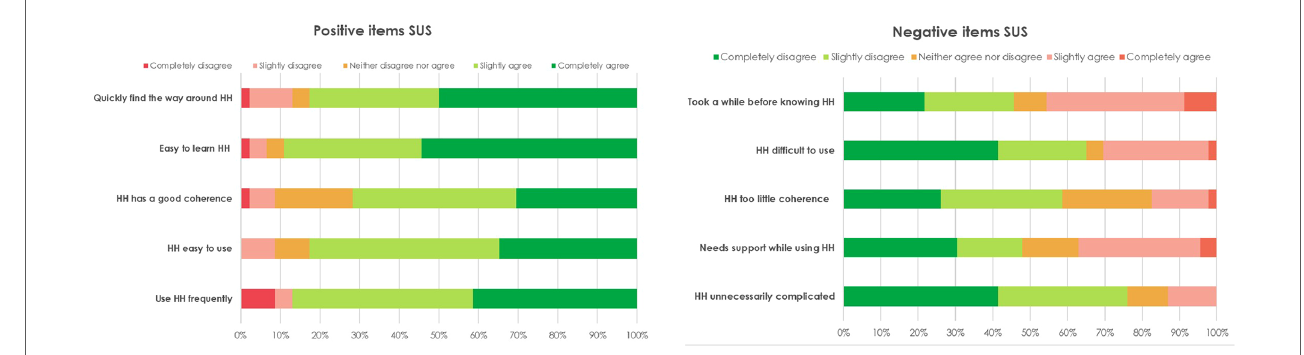
FIGURE 5 Results SUS item scores divided in negative and positive formulated